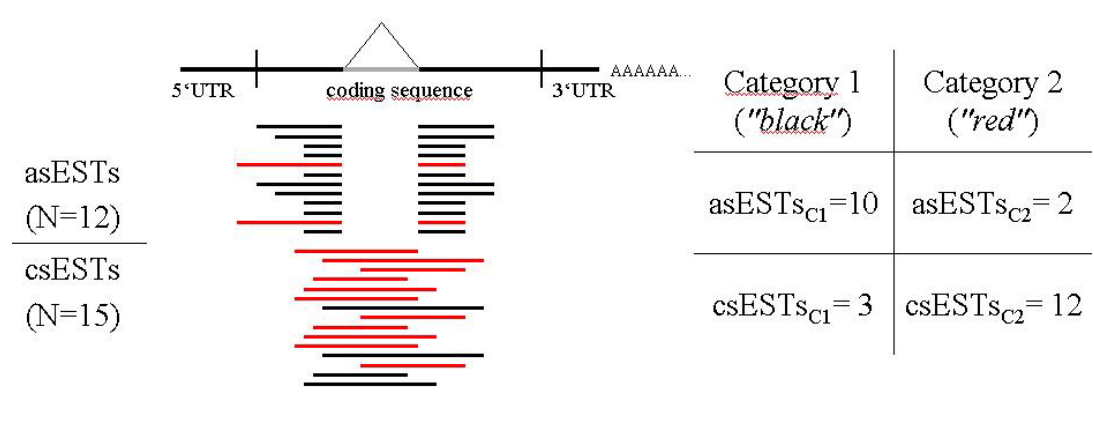
Fig.1: The strategy to categorise ESTs. In the left part, all matching ESTs are shown. The upper 12 ones are those supporting the alternative splice site (in this case: a skip of nucleotides, marked in grey). The 15 ESTs in the lower part match perfectly with the coding sequence and are defined as normally (or constitutively) spliced ESTs. Moreover, the colors red and black give the classification to category 1 and category 2, respectively. The cross table for this example is shown in the right part of this